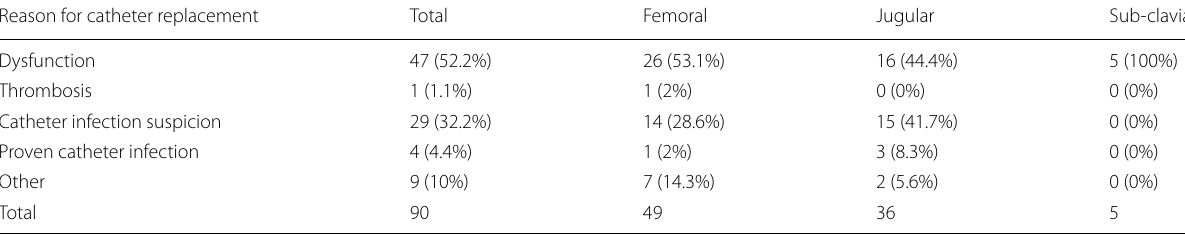
Table 5 Reasons for first catheter replacement according to insertion site